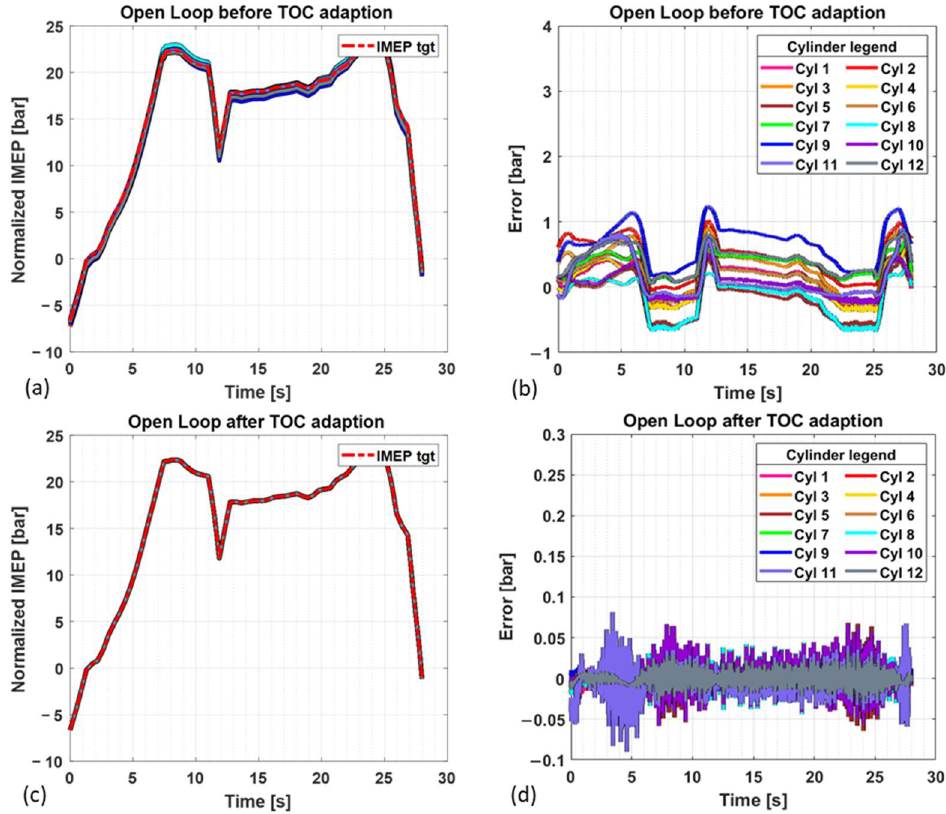
Figure 19. IMEP comparison before and after the TOC adaptation: ( a ) IMEP target and feedback before TOC adaptation, ( b ) error of IMEP before TOC adaptation, ( c ) IMEP target and feedback after TOC adaptation, ( d ) error of IMEP after TOC adaptation.